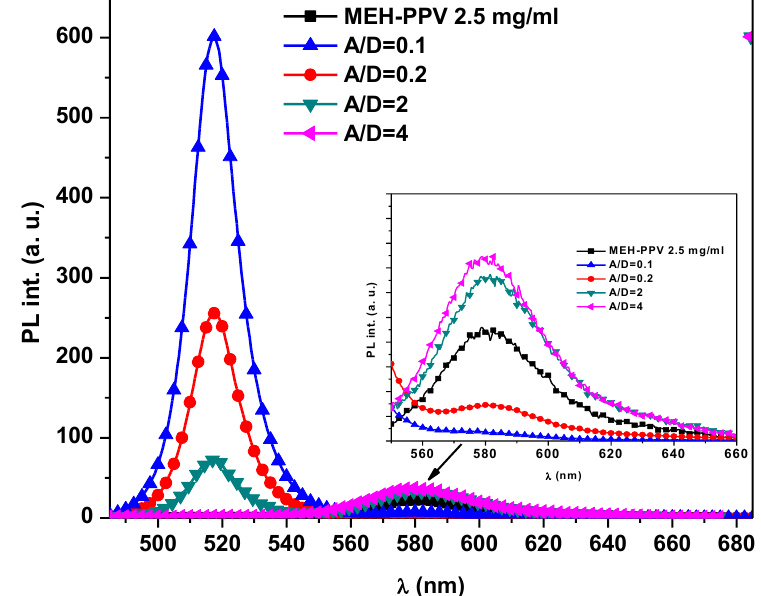
Figure 5. Fluorescence spectra of pristine MEH-PPV, and 0-D Cs 4 PbBr 6 / MEH-PPV hybrid thin Figure 5. fluorescence spectra of pristine MEH-PPV, and 0-D Cs 4 PbBr 6 /MEH-PPV hybrid thin films.